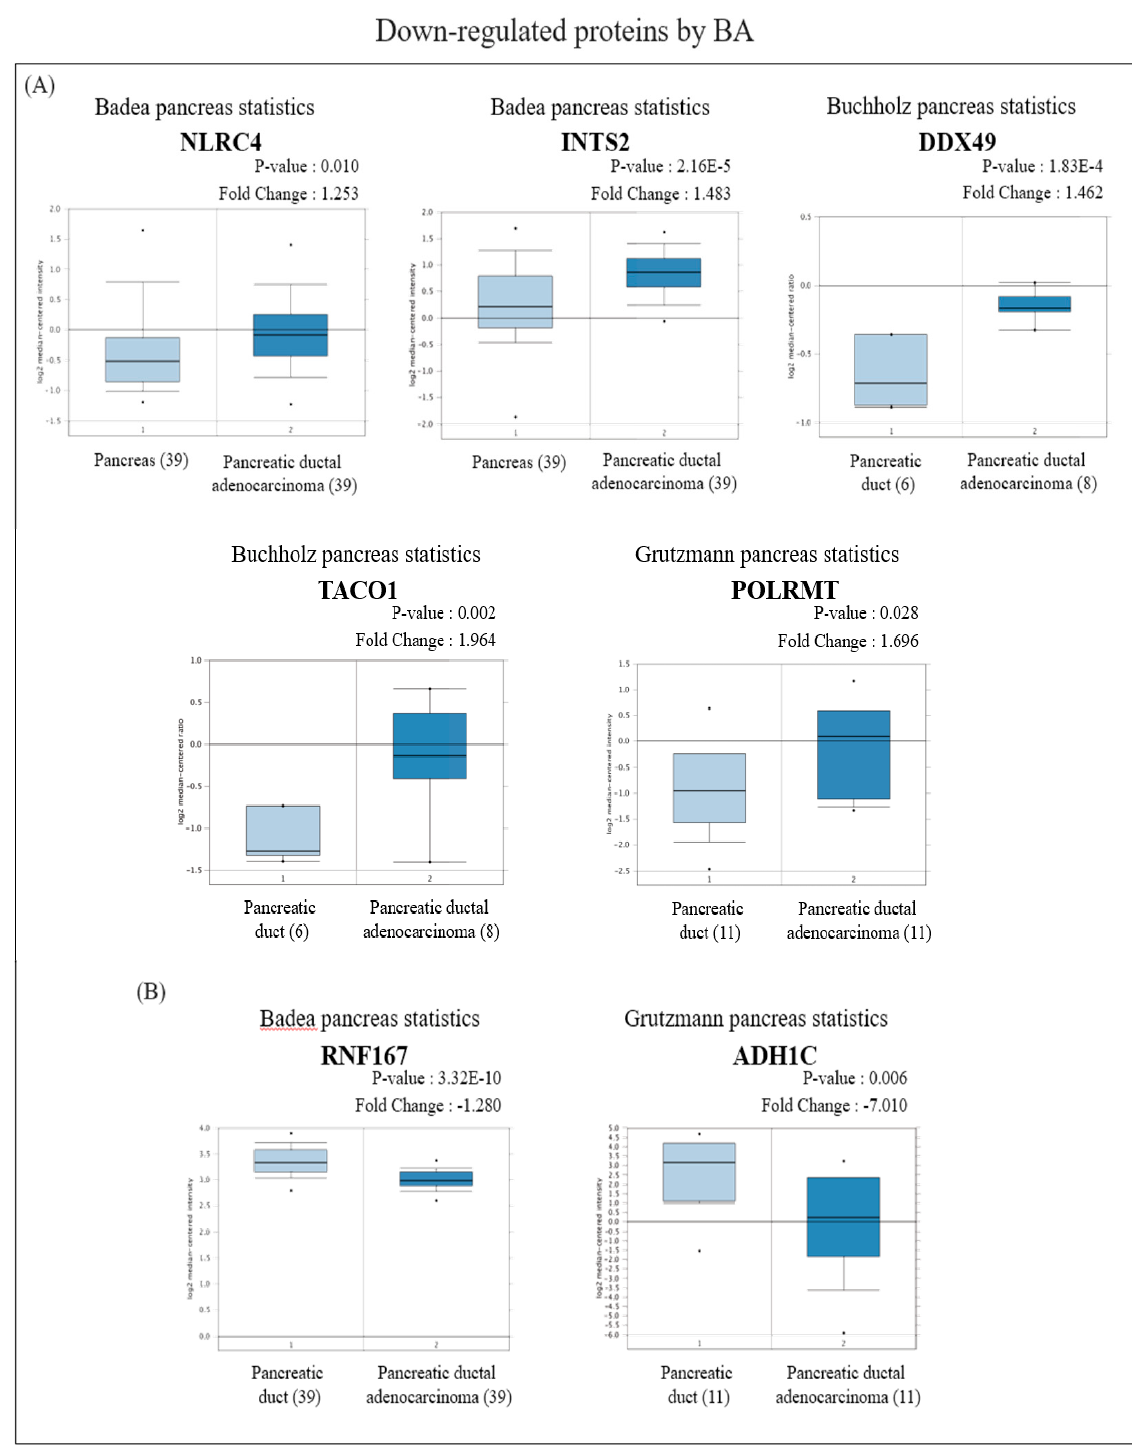
Figure 5. Analysis of the specific expressions of betulinic acid (BA)-induced downregulated proteins in clinically normal (left plot) and pancreatic ductal adenocarcinoma (PDAC; right plot) tissues using the Oncomine database. ( A ) Expressions of NLRC4 ( p = 0.010), INTS2 ( p < 0.001), DDX49 ( p < 0.001), TACO1 ( p = 0.002), and POLRMT ( p = 0.028) were significantly higher in PDAC tissues compared to normal tissues. ( B ) Expressions of RNF167 ( p < 0.001) and ADH1C ( p = 0.006) were significantly lower in PDAC tissues compared to normal tissues.